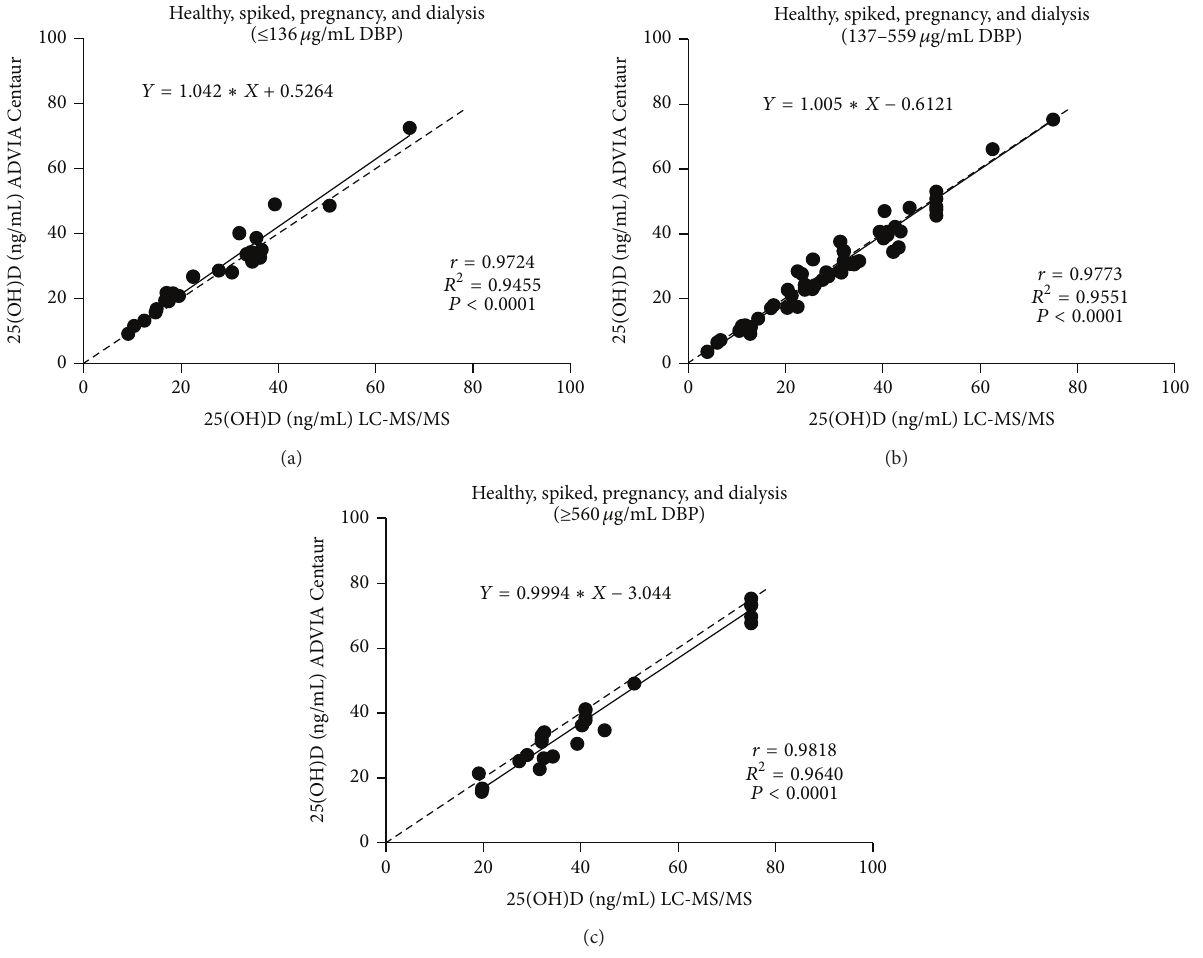
Figure2:Correlationof25(OH)DresultsobtainedfromtheADVIACentaurVitaminDTotalassayandtheLC-MS/MSmethodforcombined normal human serum pooled samples (endogenous and endogenous + spiked), pregnancy (third trimester samples), and renal dialysis samples for (a) low, (b) medium, and (c) high DBP groups. Dotted line: line of identity. To convert 25(OH)D concentrations to nanomoles per liter (nmol/L), multiply by